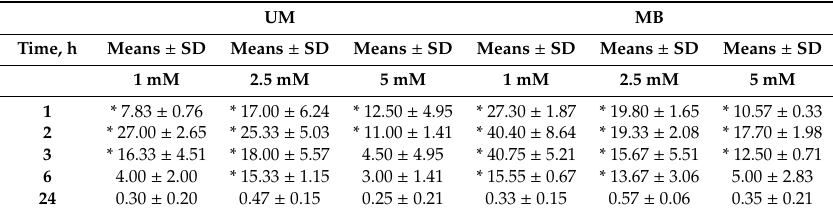
Table A1. UM and MB cell viability on Caco-2 cells over time.